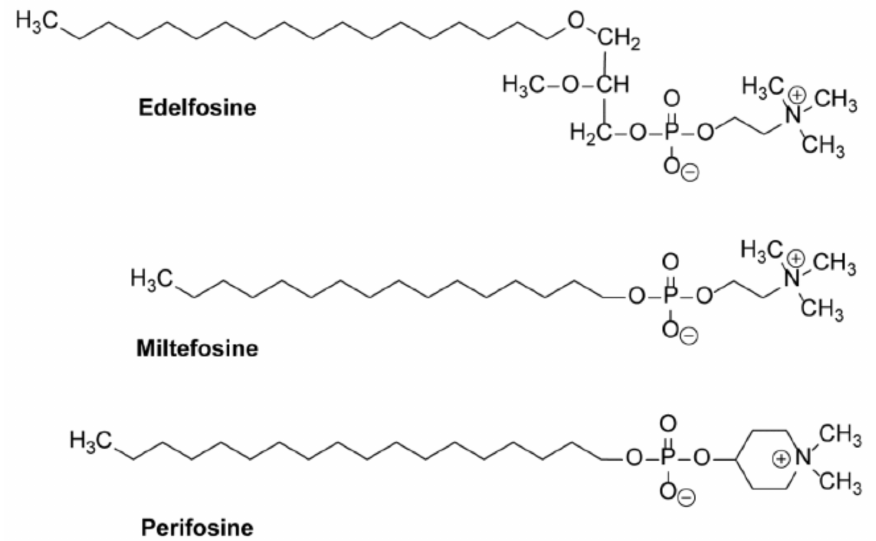
Figure 5. Chemical structures of some clinically relevant alkylphospholipid analogs (APLs). Edelfosine (1- O -octadecyl-2- O -methyl- rac -glycero-3-phosohocholine; formerly